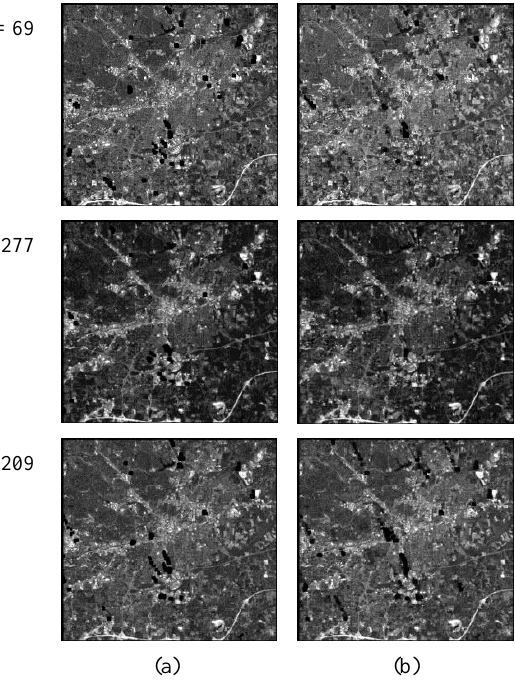
(b) Figure 8. Comparison of Landsat images with predicted results at fine spatial resolution. (a) Red bands from actual Landsat images at times t p . (b) Predicted Landsat